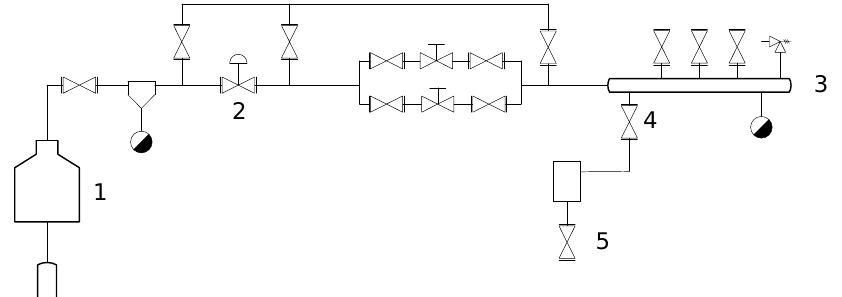
Figure 3. Steam system used for EPS production. 1: Boiler, 2: Control valve, 3: Steam header, 4: Valve, 5: Throttle valve.